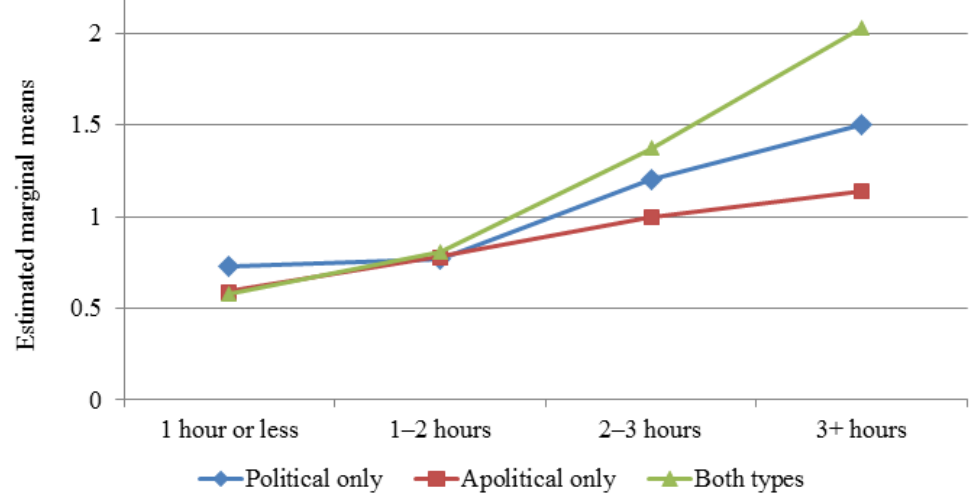
Figure 3. Relationships between types of content binge ‐ watched, frequency of streaming television and offline political participation.